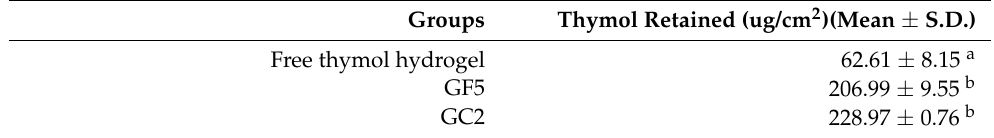
Table 2. Thymol amount retained in ski 4 h post-application of free thymol hydrogel and thymol loaded PNPs gels (GF5 and GC2).